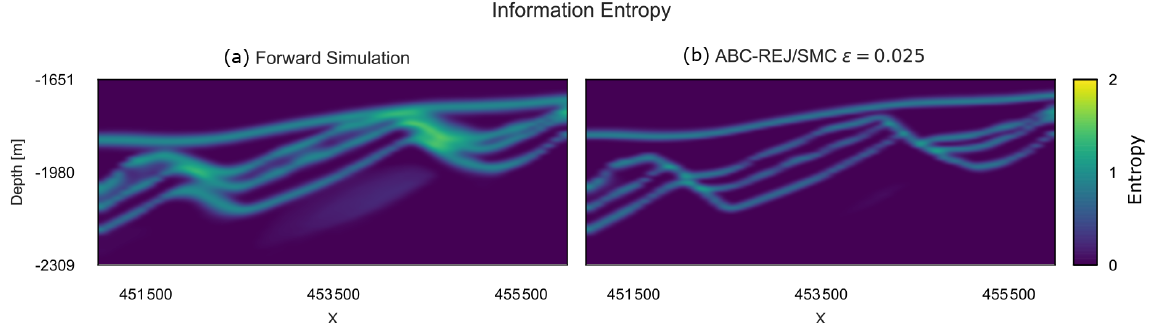
Figure 10. (a) Section of the entropy block of the forward simulation for the prior uncertainty ( H T = 0 . 223). (b) Section of the entropy block of the final epoch ( (cid:15) = 0 . 025) of the ABC-SMC simulation ( H T = 0 .